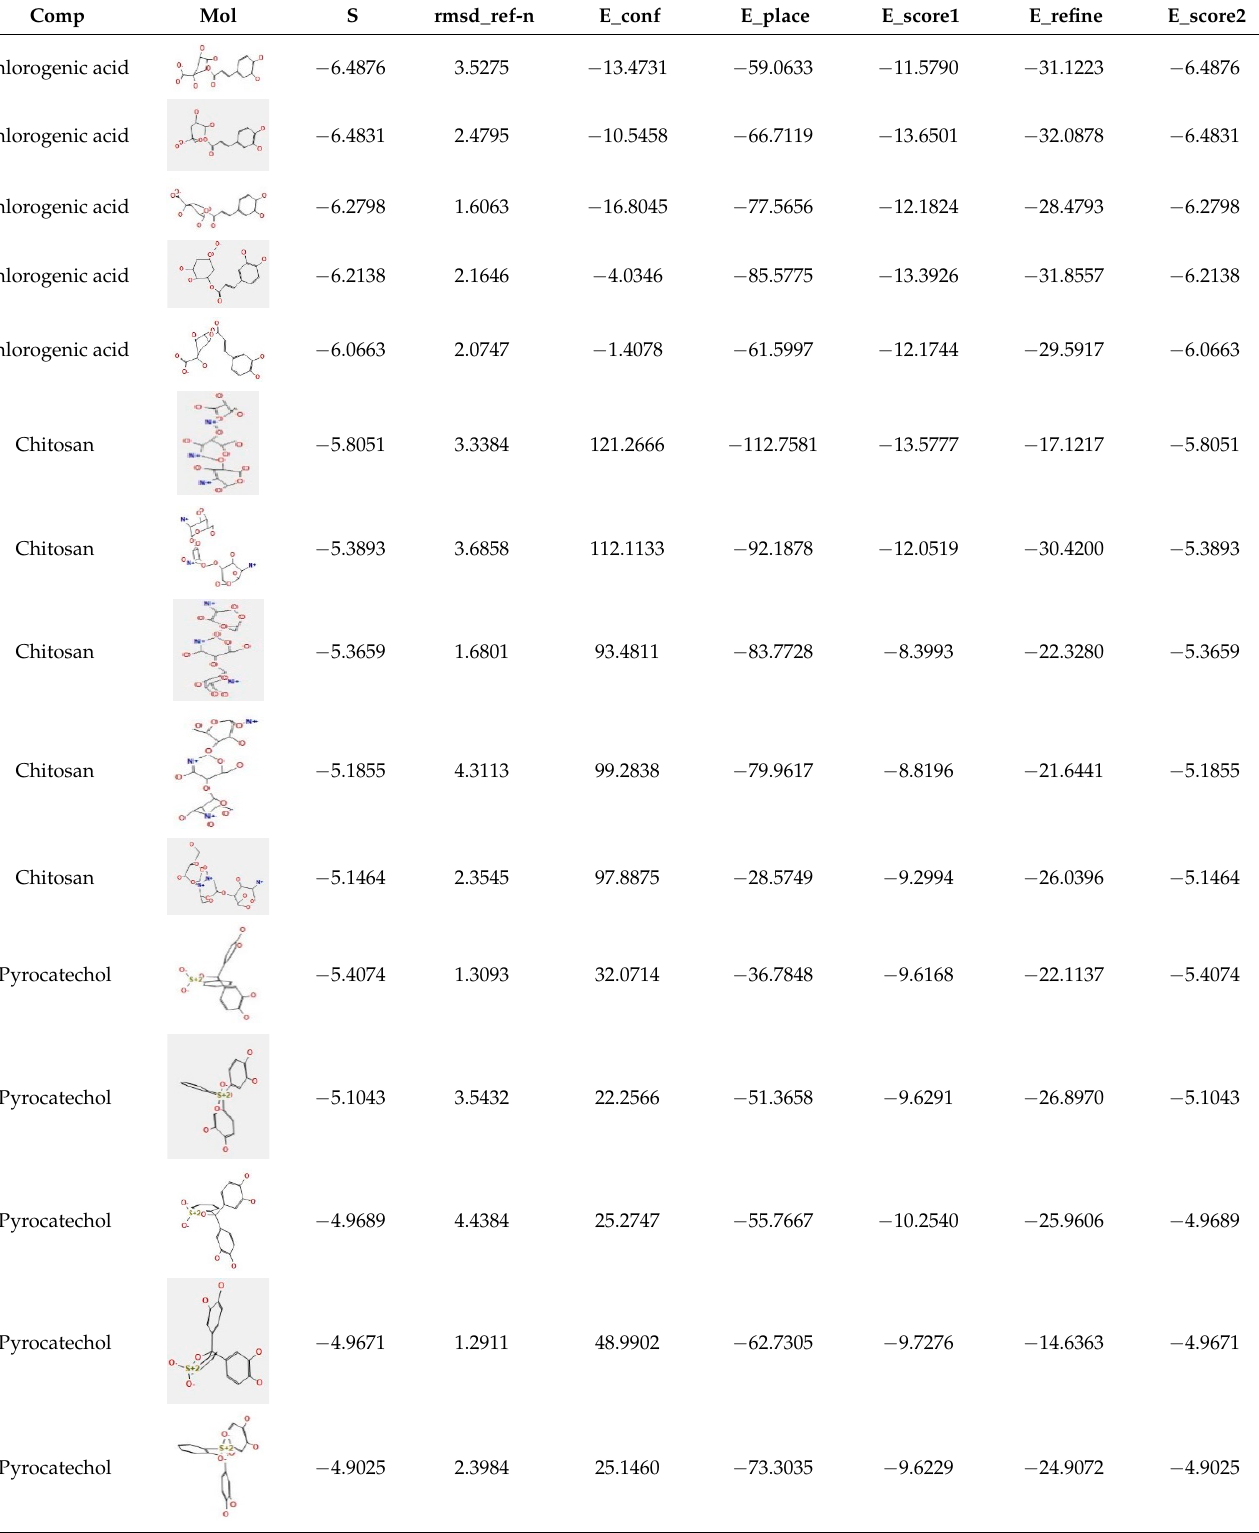
Table 5. The best possible conformations of compounds inside the protein central activity.